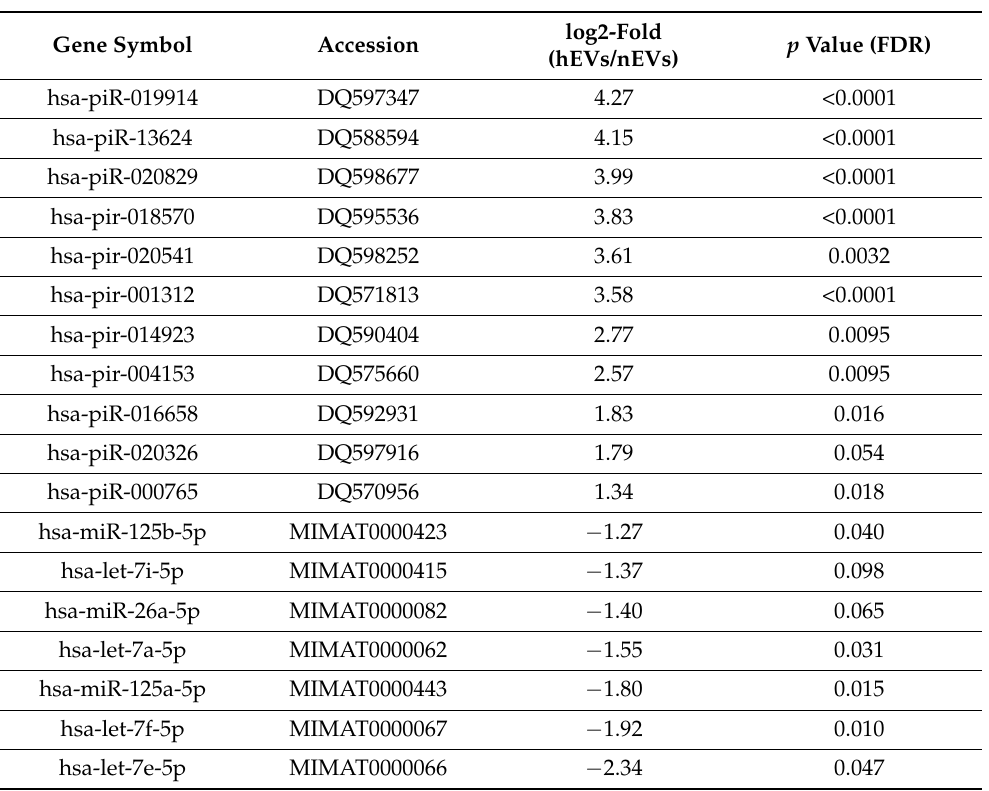
fold change ≥ 2 or ≤− 2 were considered differentially expressed (shown as